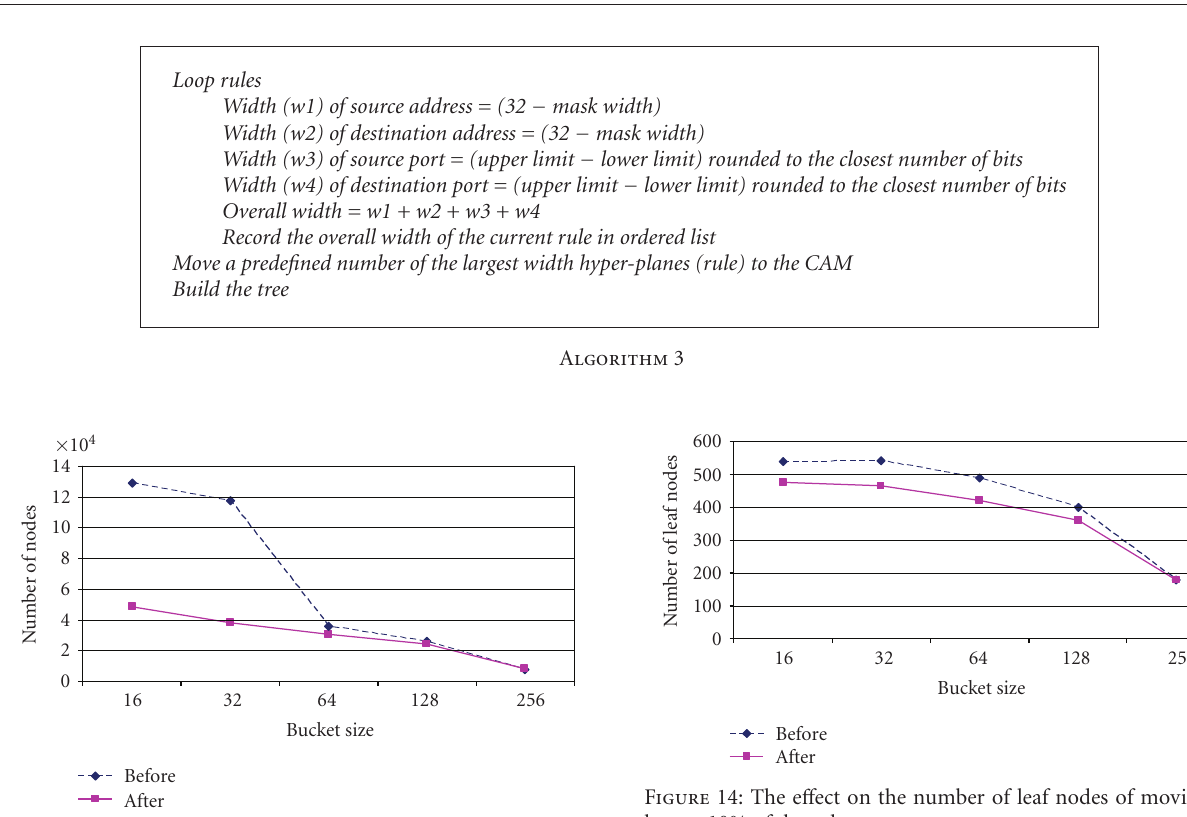
Figure 13: The e ff ect on the number of nodes of moving the largest 10% of the rules.